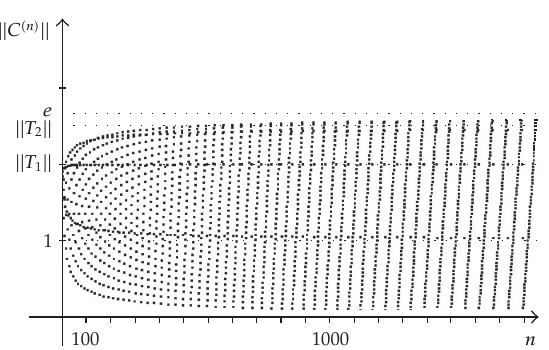
Figure 5: Sequence (cid:7) (cid:7) C (cid:7) n (cid:8) (cid:7) (cid:8)